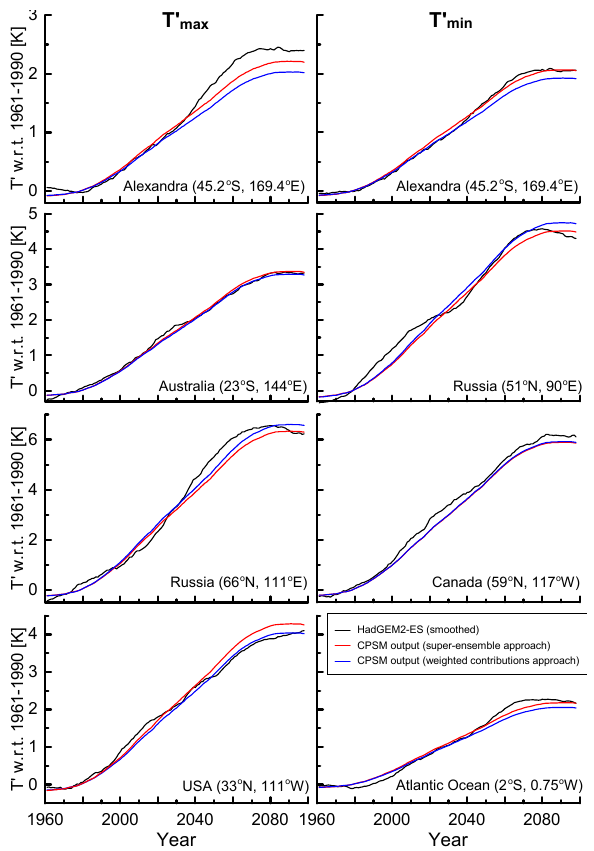
Fig. 10. Annual mean T 0 max (left column) and T 0 min (right column) time series from the HadGEM2-ES RCP 4.5 simulation (smoothed) compared to annual mean CPSM output based on the same emissions scenario using the regression model fit-coefficients from the super-ensemble (Sect. 6.1) and the weighted contributions (Sect. 6.2) approaches based on RCP 2.6 and RCP 8.5 training. Note the different scales on the y-axes. obtained using the regression model fit-coefficients derived from the RCP 8.5 simulation. In contrast, in the super-ensemble approach, the correlation between T 0 max and T 0 global is driven primarily by the strongest signal which, in this study, comes from the T 0 max time series obtained from the RCP 8.5